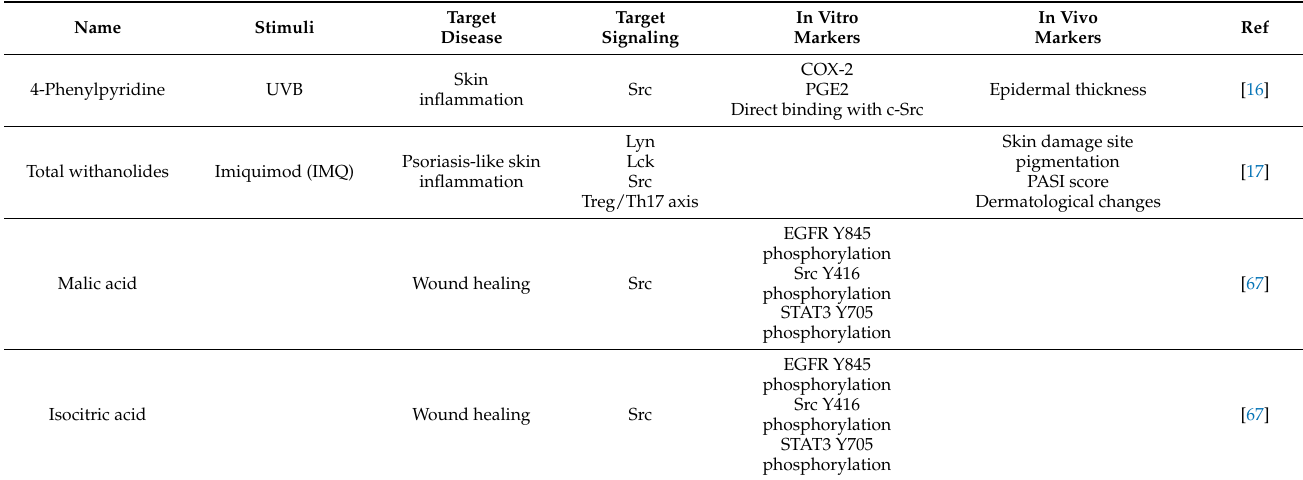
Table 2. Molecular functions of SFK - targeted phytochemicals in skin diseases.